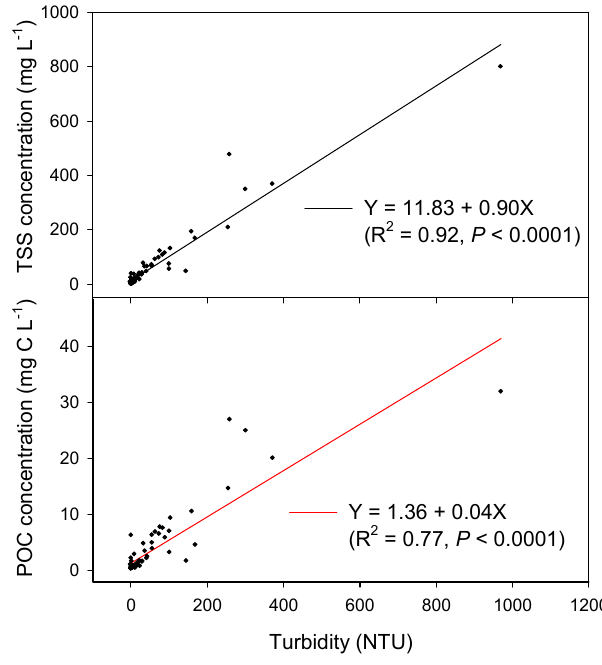
Figure 5. Relationships between event total precipitation (mm) or mean rainfall intensity (mm·h − 1 ) and event discharge-weighted mean concentration (mg·L − 1 ) of TSS, POC, and DOC. Significant relationships at p < 0.05 were indicated by drawing a regression line through the plot.